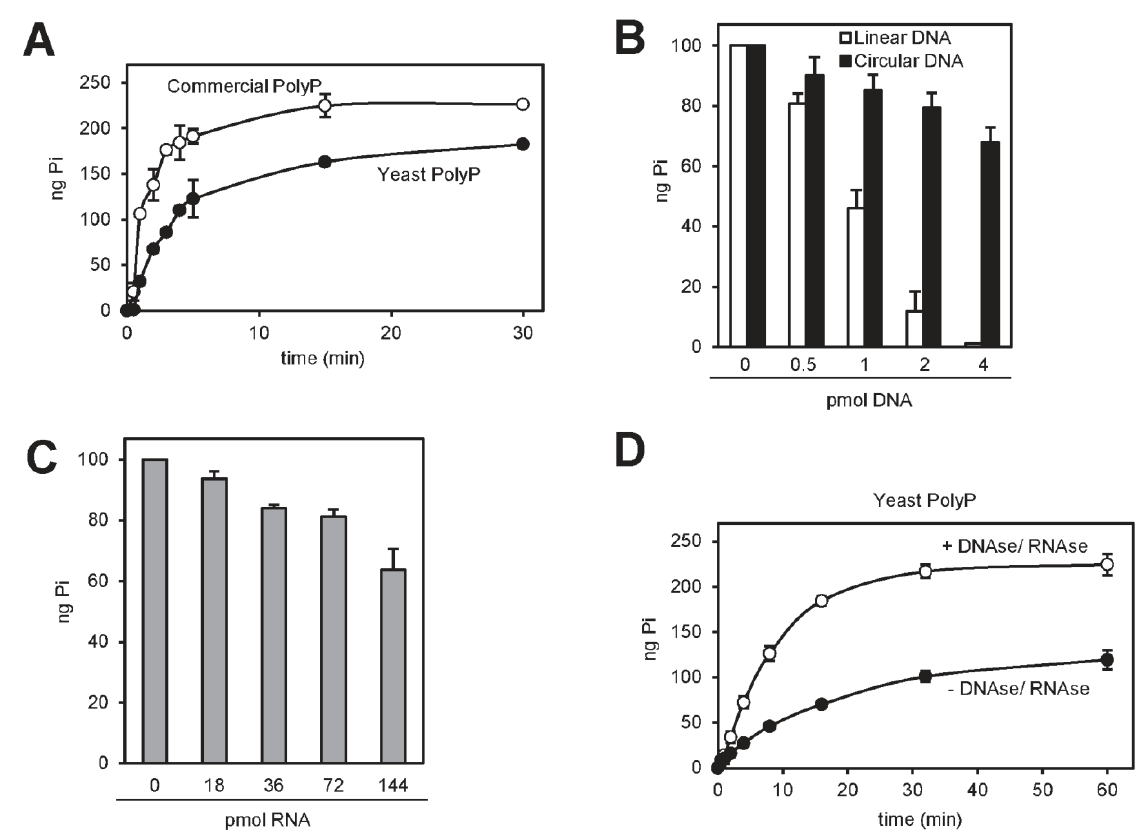
FIGURE 4: rPpx1 activity is inhibited by the presence of DNA and RNA. (A) Kinetic of the rPpx1 polyP digestion. rPpx1 (10 ng) was incubat- ed with 250 ng of commercial polyP or yeast polyP, in 20 mM Tris-HCl pH 7.50 containing 5 mM magnesium acetate and 100 mM ammoni- shown. (B) rPpx1 activity on polyP in the presence of increasing amount of DNA. rPpx1 (10 ng) was incubated with 100 ng of